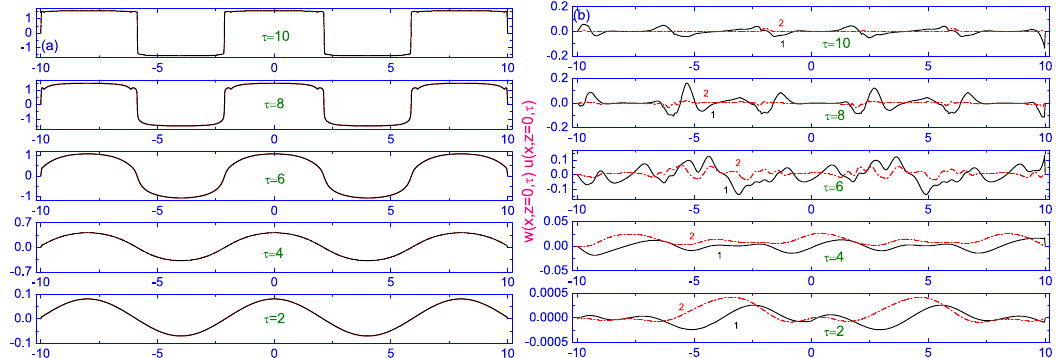
Figure 9. Plot of the evolution of the polar angle θ ( x,z = 0, τ ) ( a ) and the velocity field v = u ( x,z = 0, τ ) ˆ i + w ( x,z = 0, τ ) ˆ k ( b ) to their equilibrium distributions along the length of the dimensionless nematic cell ( − 10 ≤ x ≤ 10 ) [19], for a number of dimensionless times τ = 2, 4, 6, 8, and 10, respectively. In both cases ( a ) and ( b ) the evolutions are shown during the turned-on process (E > 0), whereas the solid (curves 1) and the dash dotted (curves 2) lines are the calculated results for the vertical w ( x,z = 0, τ ) and horizontal u ( x,z = 0, τ ) components of v ,